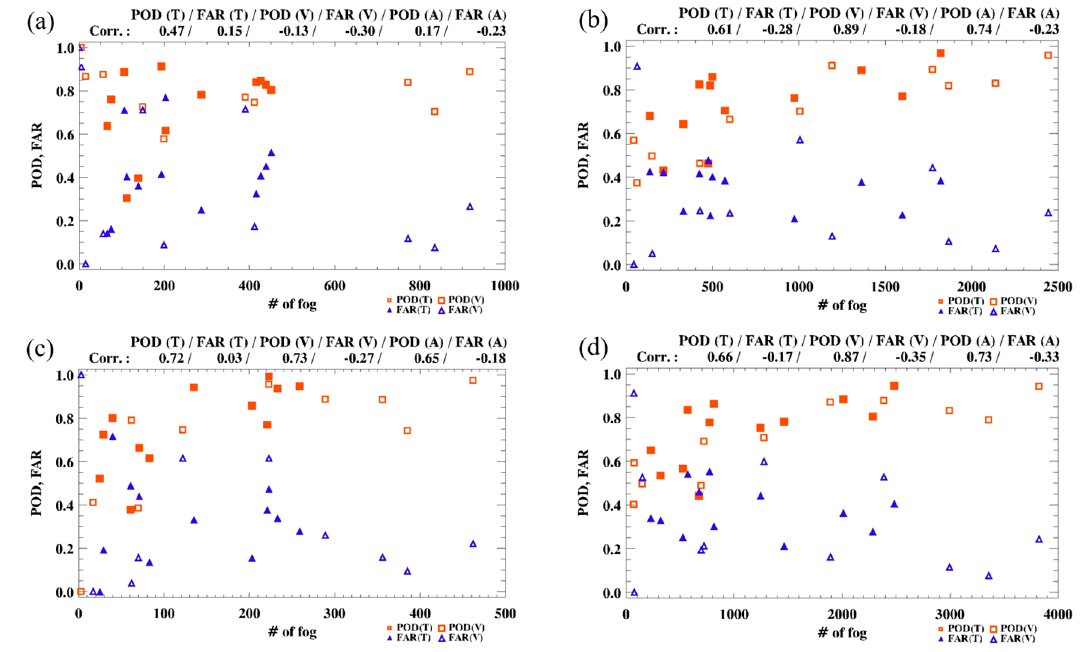
Figure 12. Scatter plots between the number of fogs and statistical skill scores (POD and FAR) based on the time of the day (( a ) day, ( b ) night, ( c ) dawn/twilight, and ( d ) total). Correlation coefficients (Corr.) between the number of fogs and statistical skill scores are shown at the top of each figure according to the training cases (T), validation cases (V), and all cases (A). Square and triangle points in each figure indicate POD and FAR, respectively. The training and validation cases are shown separately, with or without shading.